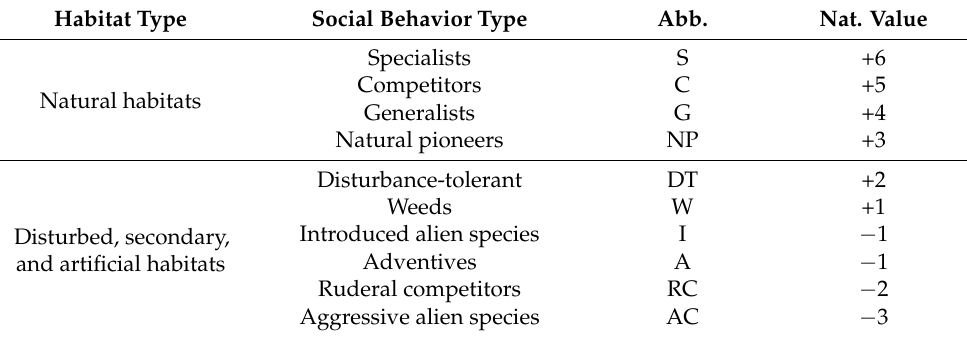
Table 1. Social behavior type categories and naturalness values [33]. Habitat Type